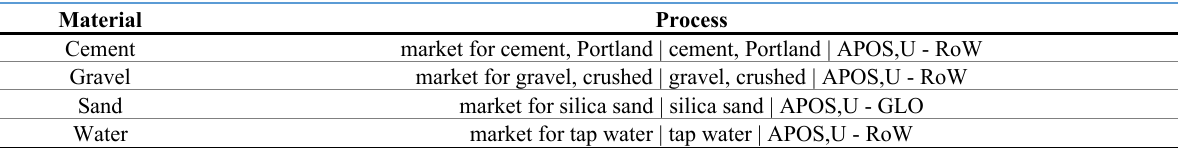
Table 3. Processes in the Life Cycle